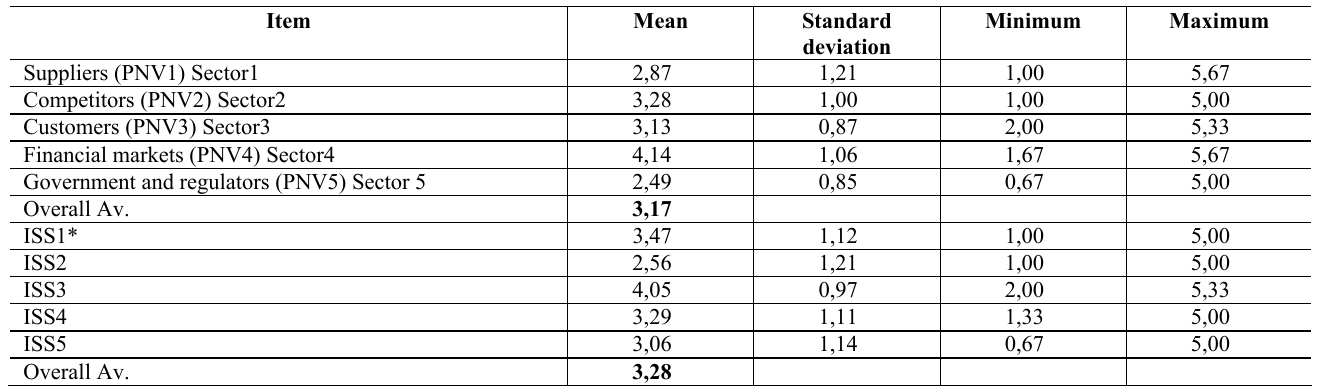
Table 4: Descriptive statistics of the response on environment uncertainty and IS support Item